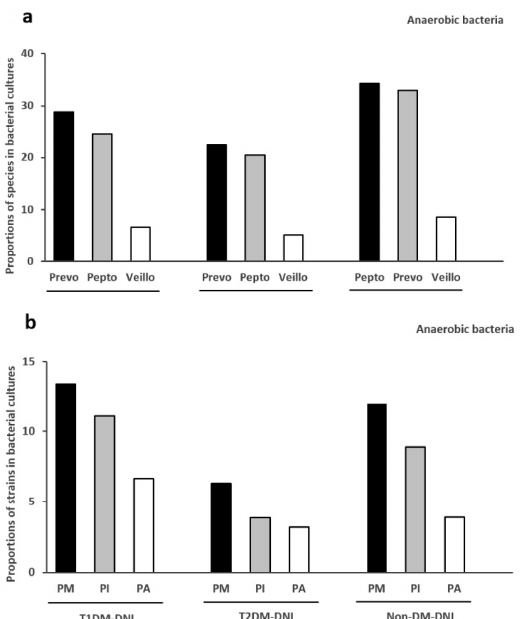
Figure 3. ( a ): Top three species of anaerobes in T1DM-DNI, T2DM-DNI, and non-DM-DNI, ( b ): Top three anaerobic bacteria in T1DM-DNI, T2DM-DNI, and non-DM-DNI. Abbreviations: Prevo, Prevotella species; Pepto, Peptostreptococcus species; Veillo, Veillonella species; PM, Peptostrep- tococcus micros ; PI, Prevotella intermedia ; PA, Peptostreptococcus anaerobius . DNI, deep neck infection; T1DM, type 1 diabetes mellitus; T2DM, type 2 diabetes